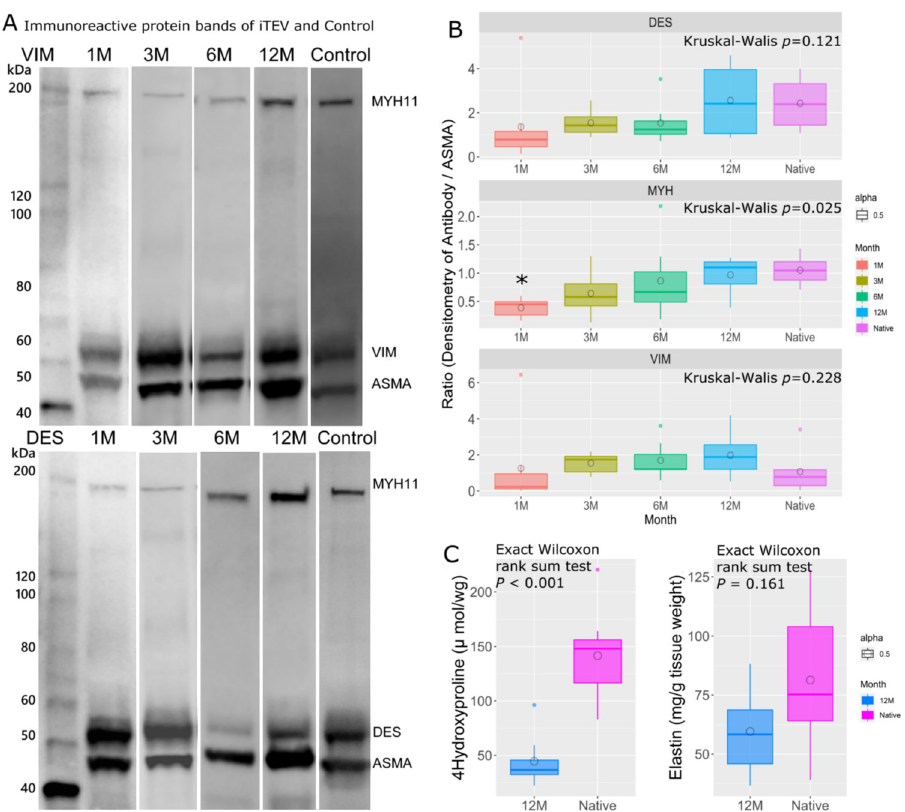
Fig 5. Biochemical protein analysis of iTEV. (A) Western blot immunoreactive protein bands for myosin heavy chain 11 (MYH11), vimentin, desmin, and α -smooth muscle actin ( α -SMA) were measured by densitometry. Immunoreactive protein bands of MYH11 are visible in a 1-month iTEV sample. (B) Box and whisker plots of MYH11, vimentin, and desmin normalized to α -SMA in native IVC and iTEV samples by month. Lines represent lower, median, and upper quartile values. Whiskers represent the extent of the remaining data. Circles represent mean values. Desmin, P = 0.121; MYH11, P = 0.026; and vimentin, P = 0.228 using the Kruskal–Wallis test. The Steel–Dwass test was used for posthoc analysis. � , P < 0.05 vs. native IVC. Box and whisker plots of 4-hydroxyproline (C) and elastin (D) in 12-month iTEV and native IVC samples. Lines represent lower, median, and upper quartile values. Whiskers represent the extent of the remaining data. Circles represent mean values. 4-Hydroxyproline, P < 0.001; elastin, P = 0.161 using the Wilcoxon rank-sum test.